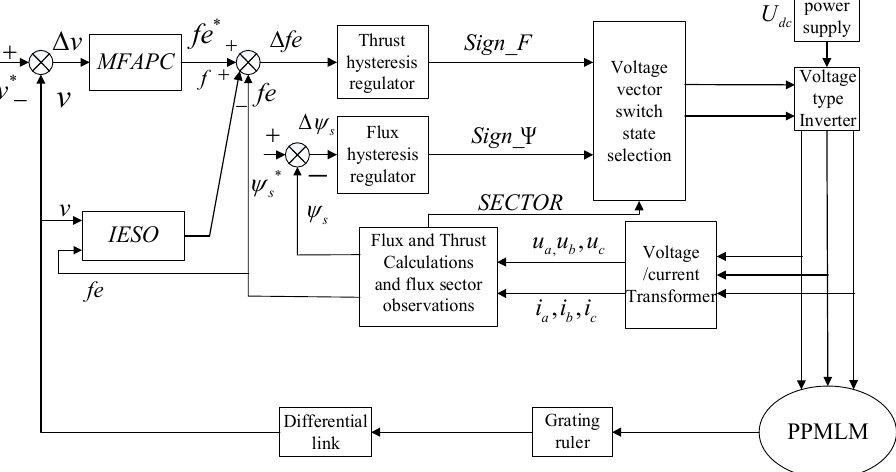
Figure 4. Block diagram of PPMLM direct thrust force control system based on IESO−CFDL−MFAPC.